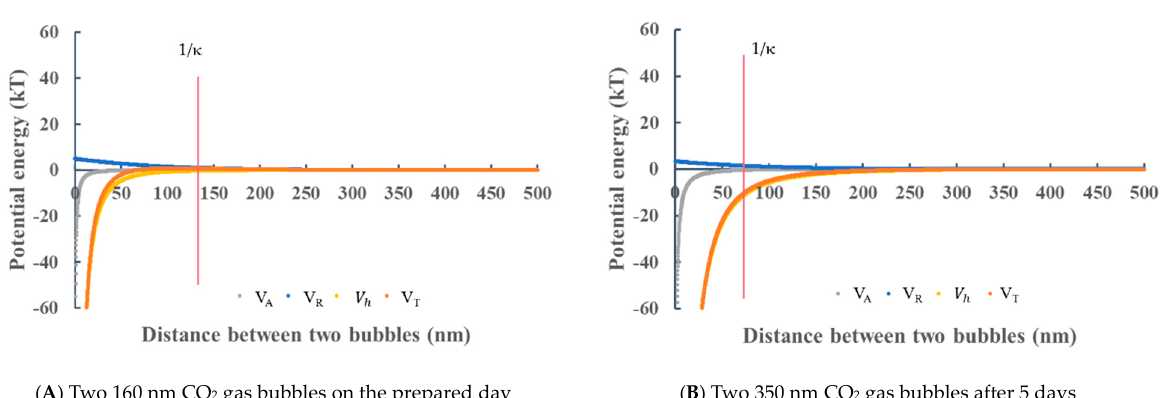
Figure 9. Total potential energy V T as a function of the distance between two nanobubbles at +9 mV zeta potential on the prepared day for CO 2 ( A ) and +5 mV after 5 days for CO 2 nanobubble ( B ) in deionized water. ( A ) Two 160 nm bubbles on the prepared day, ( B ) two 350 nm bubbles after 5 days.